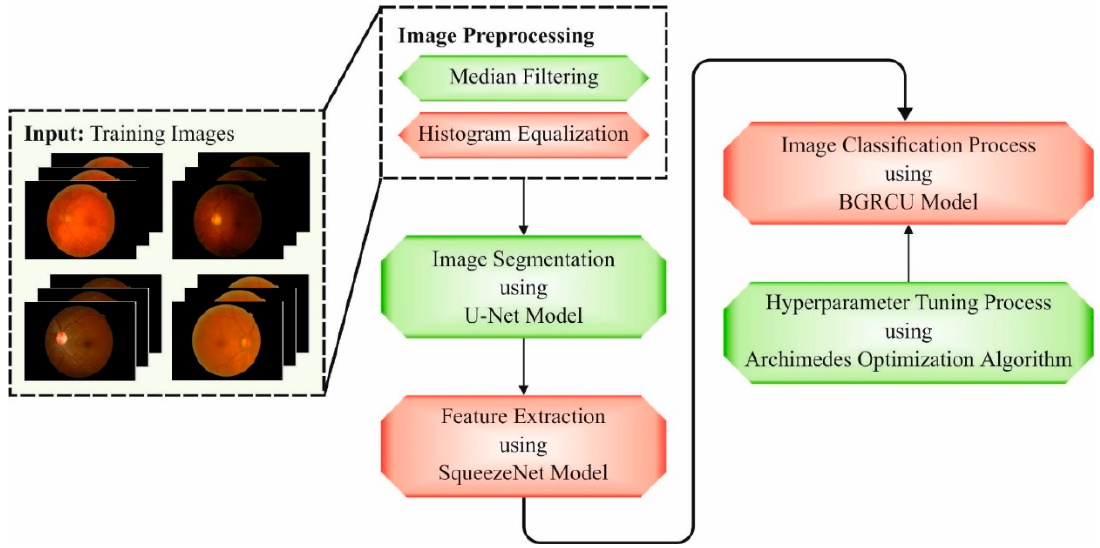
Figure 1. Block diagram of the XAITO-DRGC approach.